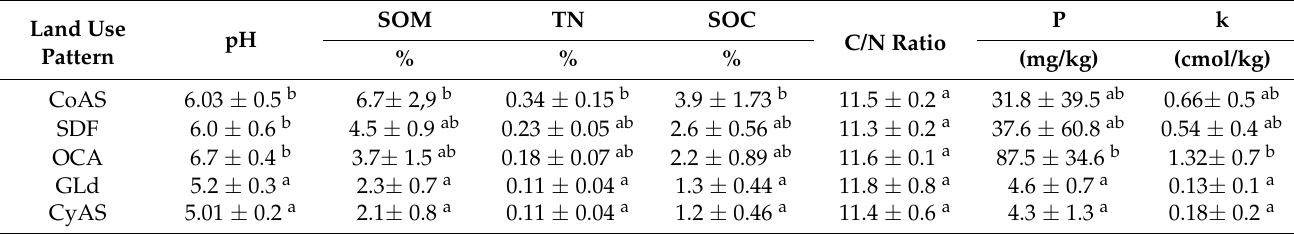
Table 3. Average values of chemical properties of the soil for the different L-UCH classes, including their standard deviations (15 repetitions for each L-UCH class). The different letters mean significant difference ( p < 0.05, HSD Tukey). SOM: soil organic matter. TN: total nitrogen. SOC: soil organic carbon. Land Use